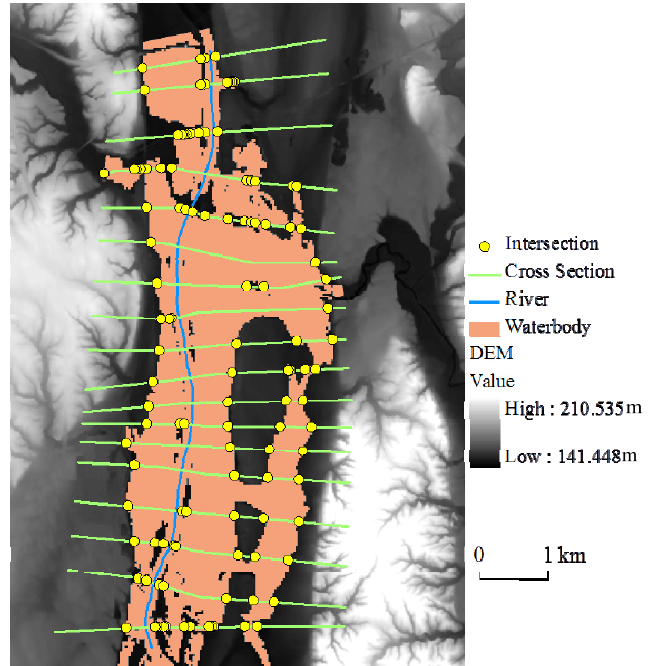
Figure 4. Intersection points for reading water surface elevation from DEM (Montezuma reach, 11 June